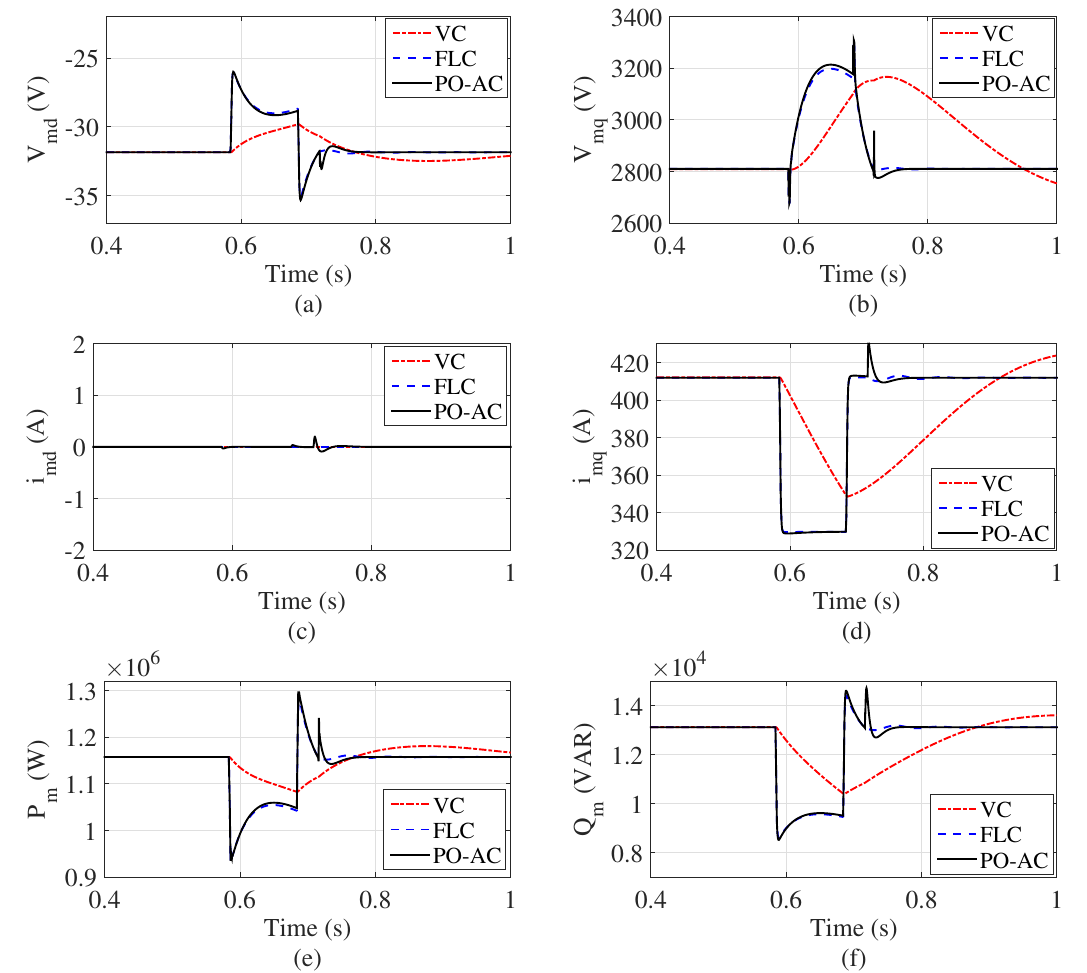
Figure 13. Responses of the PMSG to constant wind speed with protection under grid voltage dips. ( a ) d-axis voltage V md . ( b ) q-axis voltage V mq . ( c ) d-axis current i md . ( d ) q-axis current i mq . ( e ) Active generating power P m . ( f ) Reactive generating power Q m .